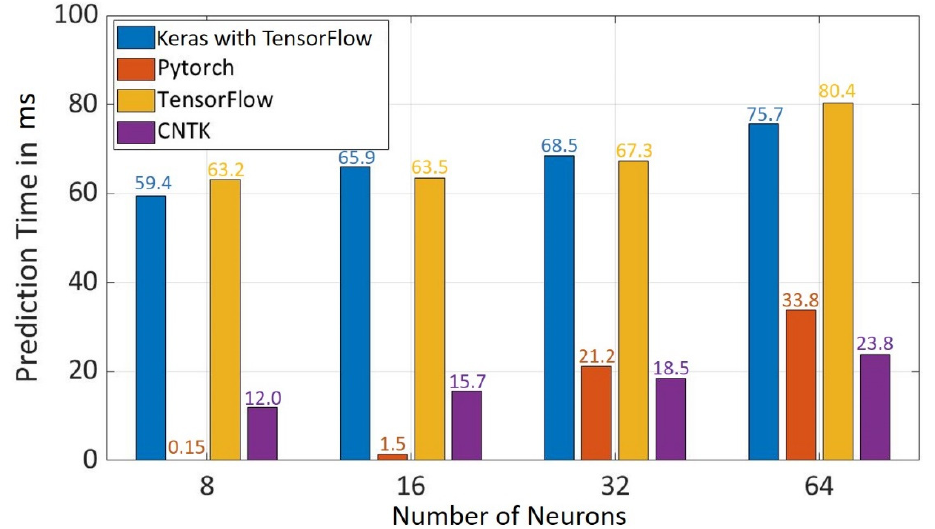
Figure 10. Prediction Time for Different Frameworks using Different Number of Neurons in Hidden